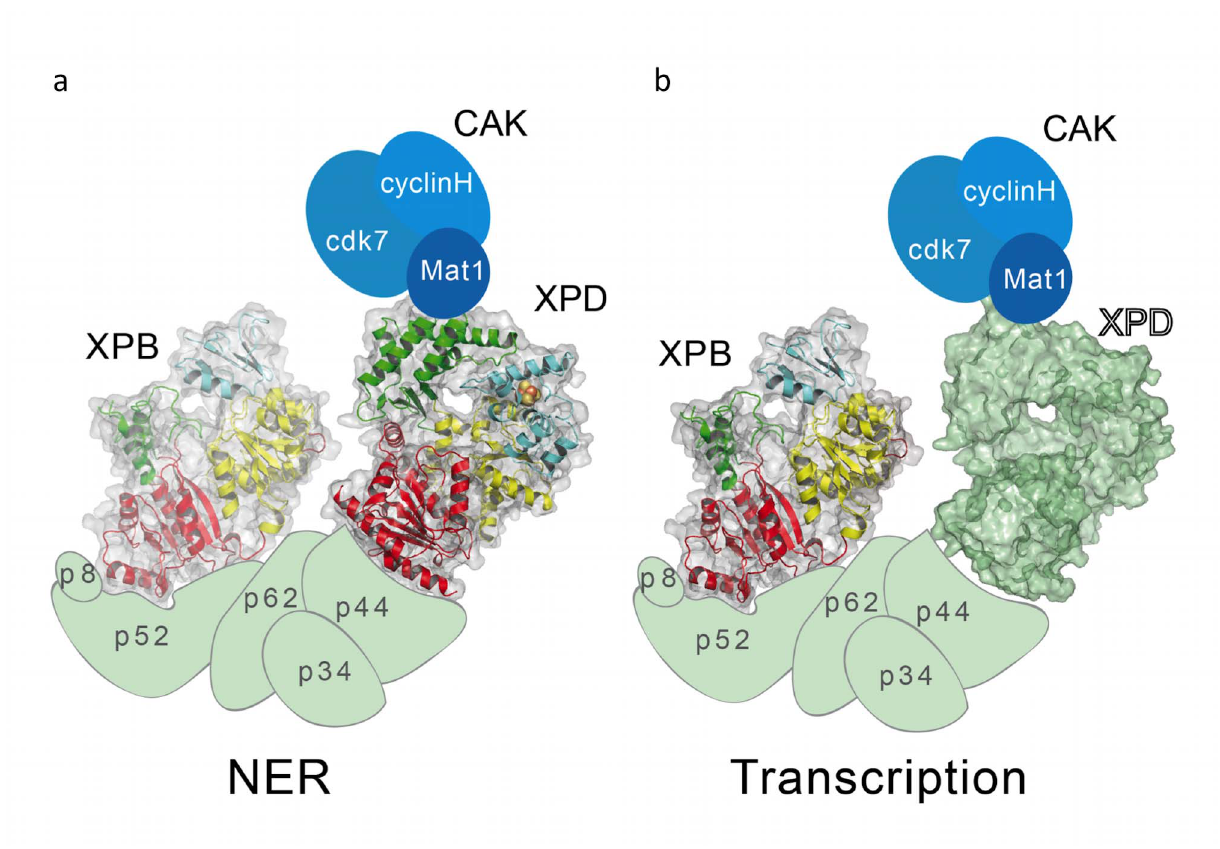
Figure 6. Model of the different XPD and XPB functionalities in NER and transcription. (a) In NER, XPD and XPB act as enzymes and have to mediate protein–protein interactions. XPD [3,27,29] and XPB [30,31,50] are shown as a cartoon with their molecular surface. The other subunits are depicted schematically. (b) As in (a), with the exception that the cartoon for XPD has been omitted and XPD is shown in green to exemplify that only the ‘‘shell’’ of XPD is needed for